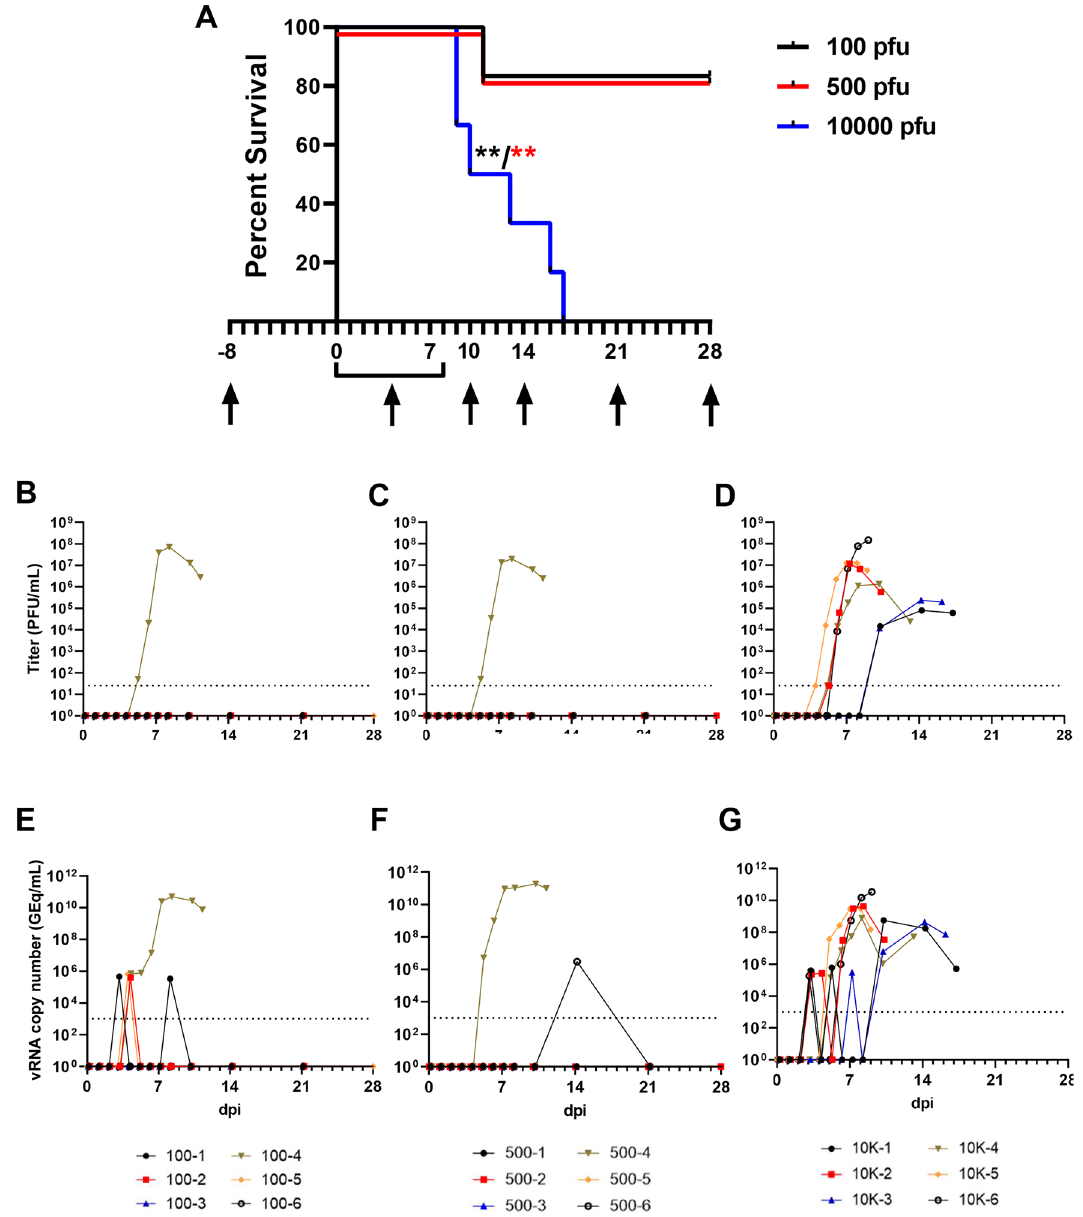
Figure 1. Survival analysis and determination of viral load in EBOV-challenged macaques. ( A ) Kaplan–Meier survival curves of cynomolgus macaques challenged with low (100–500 PFU) and high (10,000 PFU) doses of EBOV variant Makona. Arrows below x-axis denote scheduled sampling days. Colored asterisks denote statistical significance to the same colored group. **p ≤ 0.01. Viral load was determined by plaque titration of plasma ( B – D ) and RT-qPCR detection of EBOV vRNA ( E – G ) from whole Quantitation of EBOV vRNA and infectious virus load. We assessed levels of circulating infectious EBOV in plasma and EBOV RNA (vRNA) in whole blood by plaque assay and RT-qPCR, respectively. In both lower dose groups, infectious EBOV was only recovered in animals that developed fatal disease (Fig. 1B,C) while all animals developed levels of circulating infectious virus in the high dose group (Fig. 1D). In the two animals from the high dose cohort exhibiting the most protracted time-to-death (TTD) (euthanized at 16 and 17 dpi), detectable levels of circulating infectious EBOV and vRNA developed later and at lower titers than in the animals with a shorter disease course (Fig. 1D,G). Circulating vRNA was detected transiently in 3/6 and 1/6 survivors from the 100 and 500 PFU challenge cohorts, respectively (Fig. 1E,F). Tissues were collected at necropsy and assayed for the presence of vRNA and infectious EBOV. vRNA was primarily restricted to lymphoid tissue, liver, spleen, and lungs in surviving animals from the 100 PFU cohort (Fig. S4A) but was also found in low abun- dance (~ 10 4 Genomic Equivalents/gram (GEq/g) tissue) in the eye and transverse colon of one survivor (100-5). Similarly, vRNA was absent in most tissues from surviving animals in the 500 PFU challenge cohort; however,